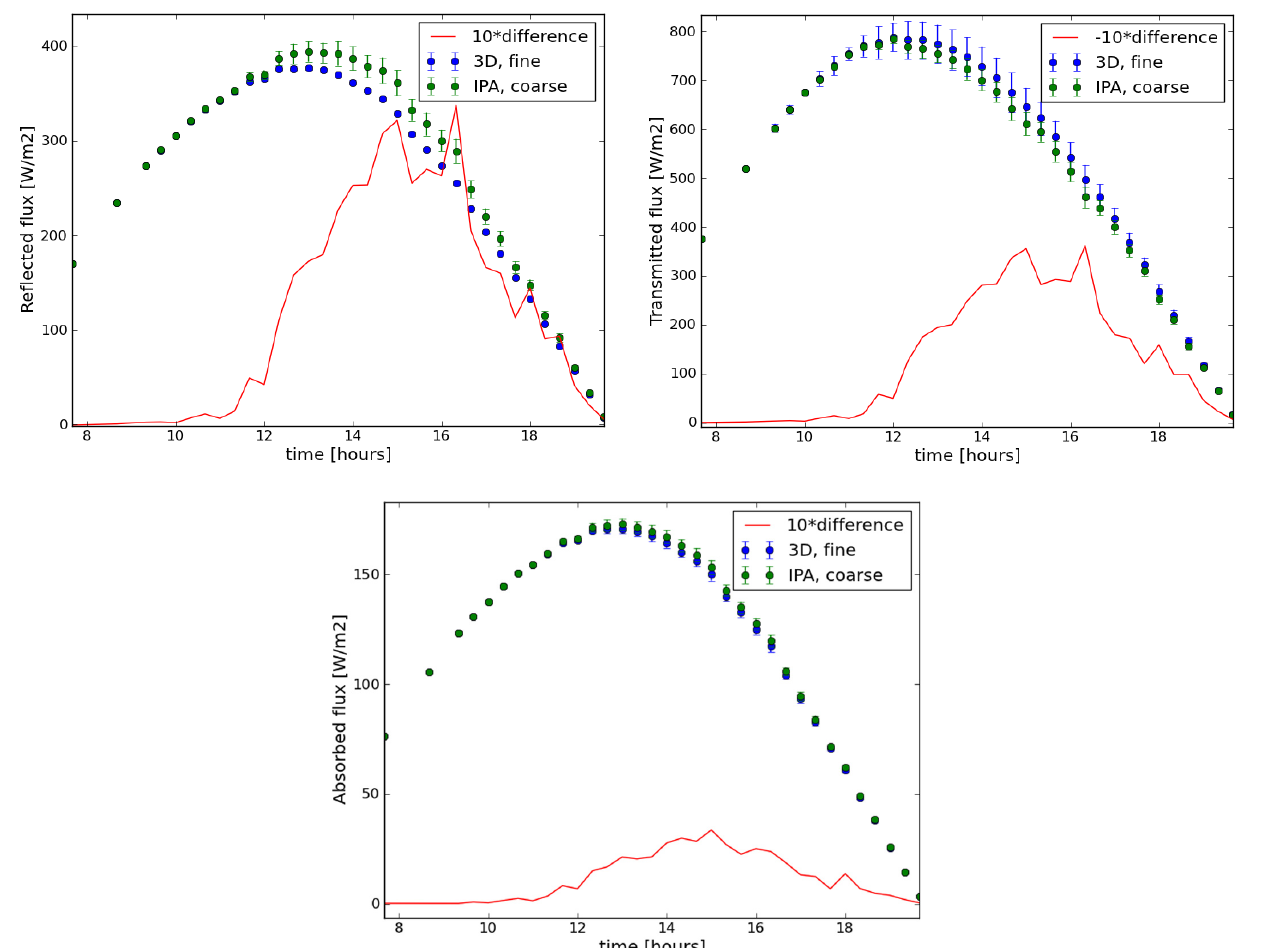
Fig. 8. Radiation fields in a diurnal cycle of shallow cumulus clouds developing over land (see Fig. 3). The left panel shows the reflected flux at the top of the atmosphere, the right top panel, the transmitted flux at ground and the right bottom panel, the absorbed flux through the whole atmosphere. Note that all plots show the shape of the incoming solar radiation which depends on solar zenith angle. The red line represent the bias of the coarse radiation fields in comparison to the high resolution ones. Note that a factor of 10 has been applied to the biases for plotting convenience ( − 10 in case of transmitted flux). See text for the explanation of the features.